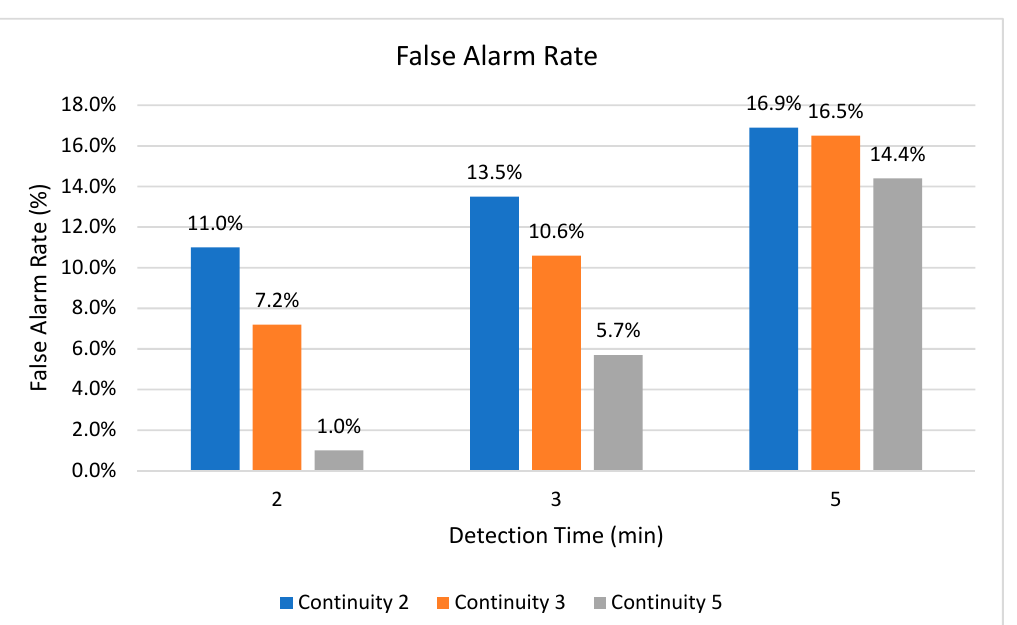
Figure 10. Detection rate.